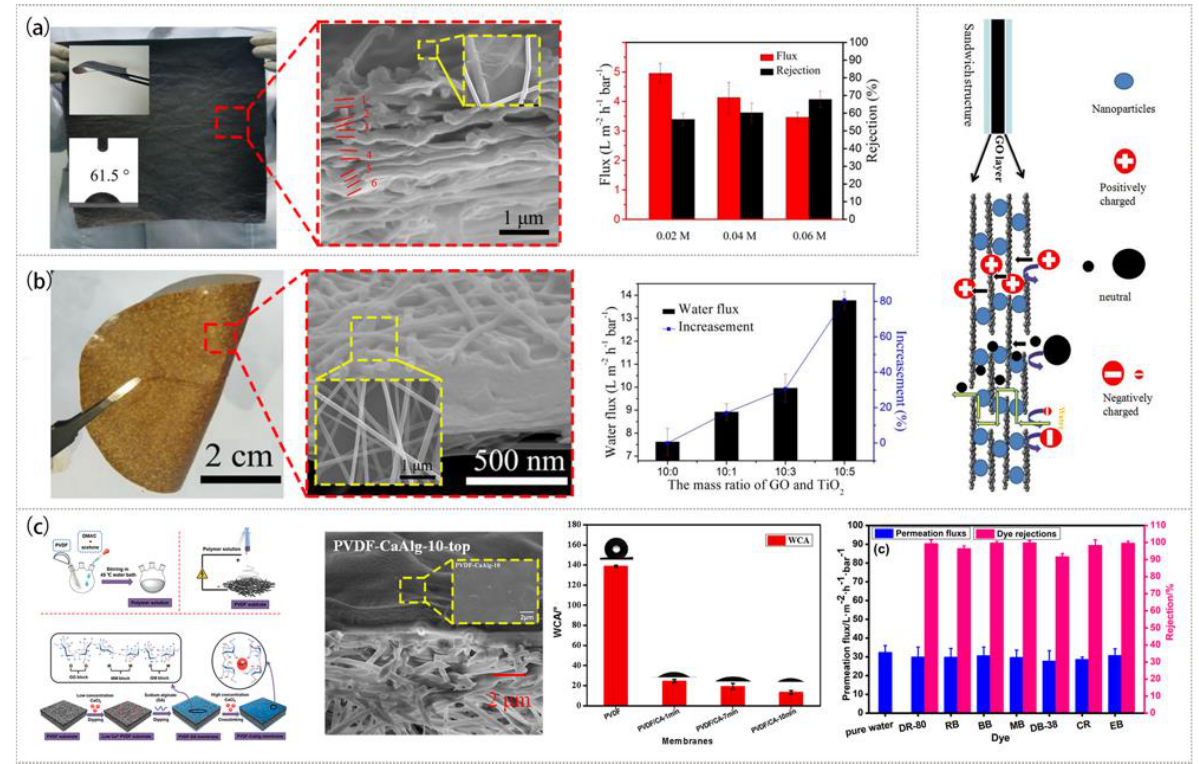
Figure 5. Preparation process, microstructure, and properties of NF membranes: ( a ) GO@Nylon 6 membrane. Reprinted with permission from Ref. [83]. Copyright 2018 Elsevier Ltd. ( b ) (PA 6@GO@PA 6)/TiO 2 membrane. Reprinted with permission from Ref. [84]. Copyright 2018 Elsevier Ltd. ( c ) PVDF-Alg membrane. Reprinted with permission from Ref. [87]. Copyright 2021 Elsevier Ltd.